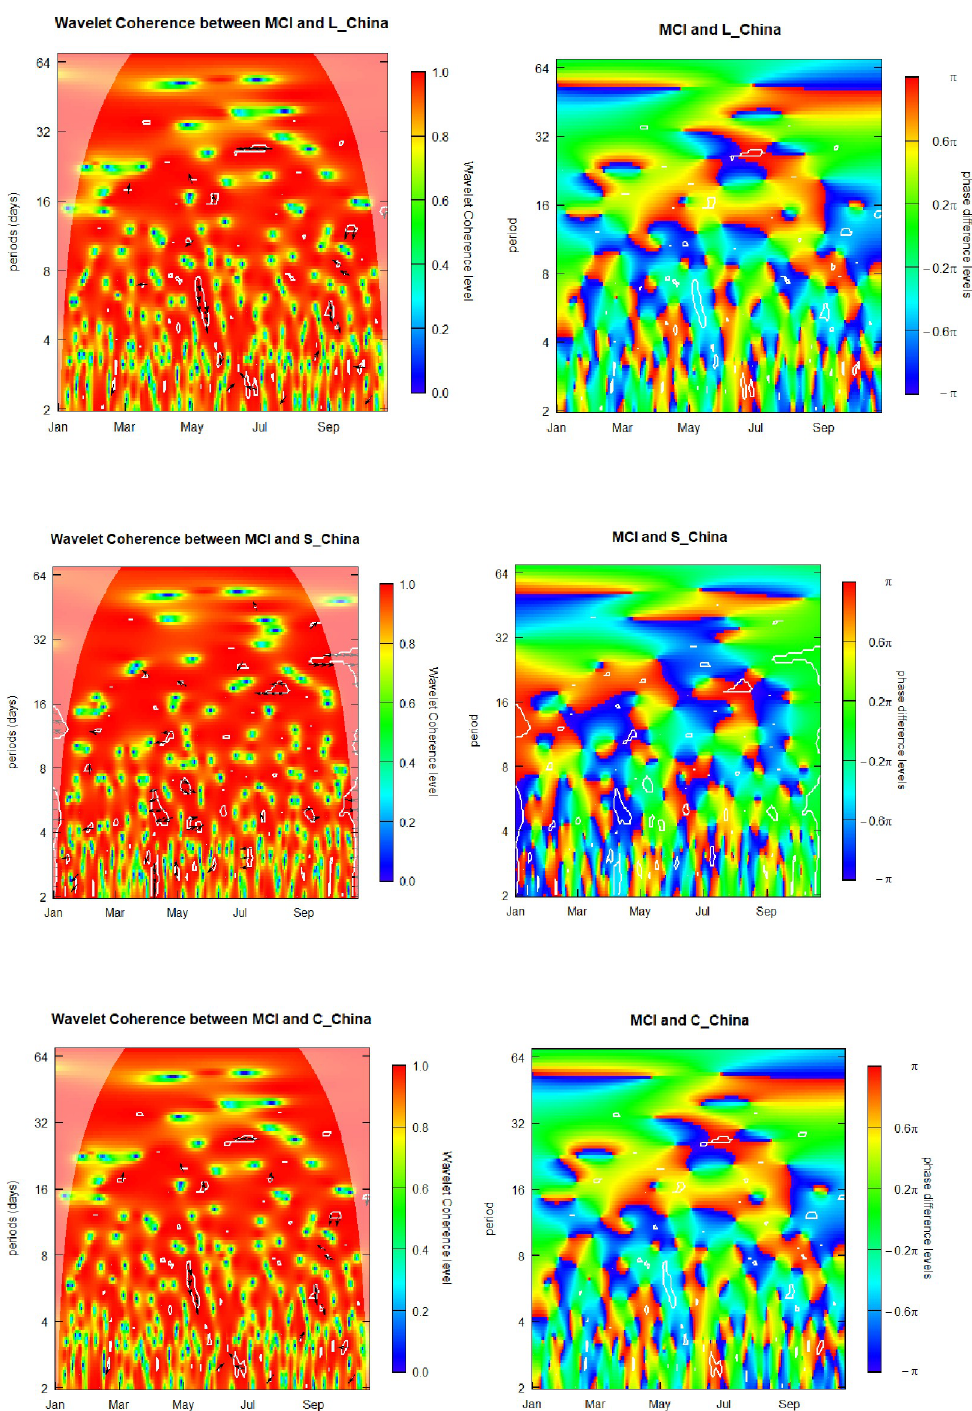
Fig 4. Media Coverage Index (MCI) and sovereign yield components of China. L_China, S_China, and C_China denote the level, curvature and slope component for